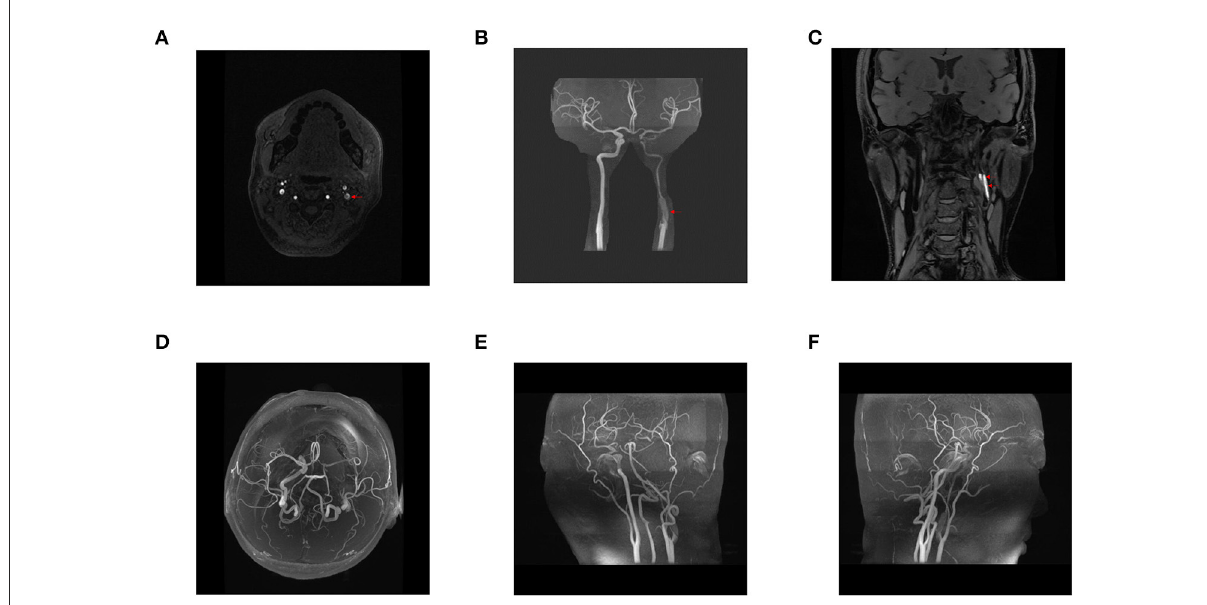
FIGURE1 Preoperative head and neck magnetic resonance angiography (MRA), three-dimensional reconstruction of head and neck MRA, and blood flow assessment. A dissection at the origin of the left internal carotid artery was observed, and the left internal carotid artery was severely stenosed (A–C) . Stenosis at the origin of the left internal carotid artery was associated with an intermural hematoma (C) . The right internal carotid, bilateral middle, and anterior cerebral arteries showed no apparent thickening, stenosis, or signal loss (D–F) . The bilateral vertebral, basilar, posterior cerebral arteries and their branches were clearly displayed, with no obvious thickening and stenosis (E,F) . The bilateral posterior communicating arteries were found opened (D) . Blood flow assessment: arterial spin labeling (ASL) revealed a basic symmetry of cerebral blood flow in both cerebral hemispheres.